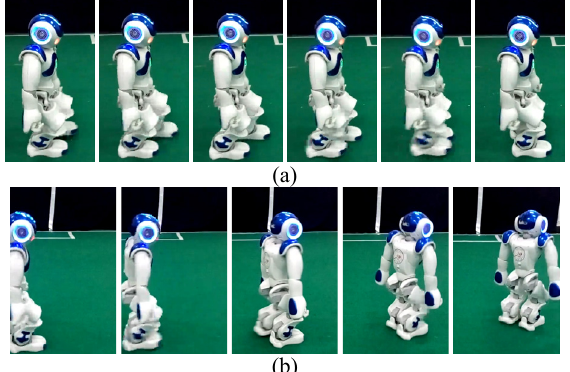
Fig. 12. Real walking test. (a) Straight walking test. (b) Rotation